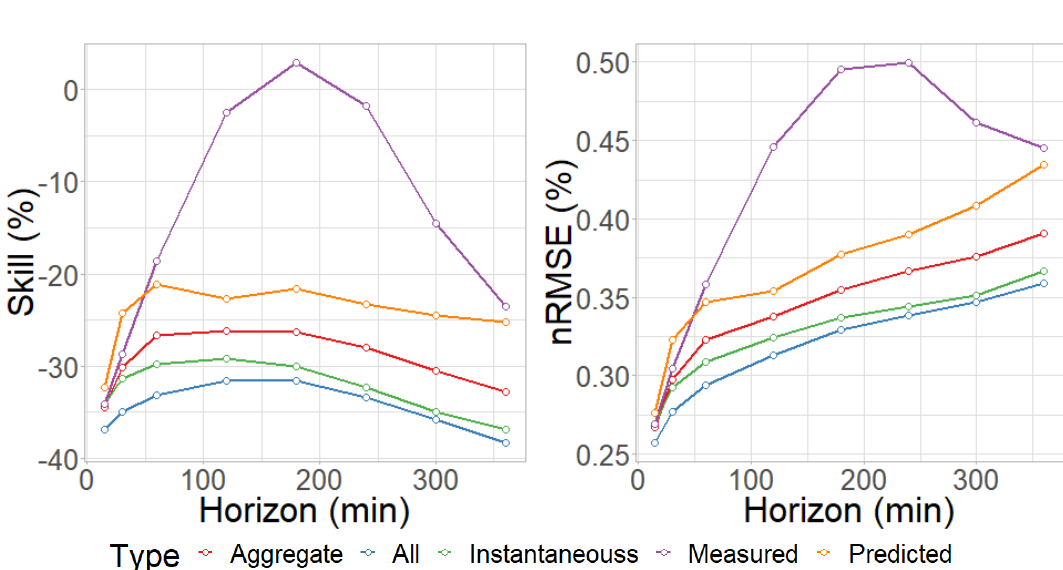
Figure 3. Mean Performance of Experiments measured in Skill ( Left ) and NRMSE ( Right